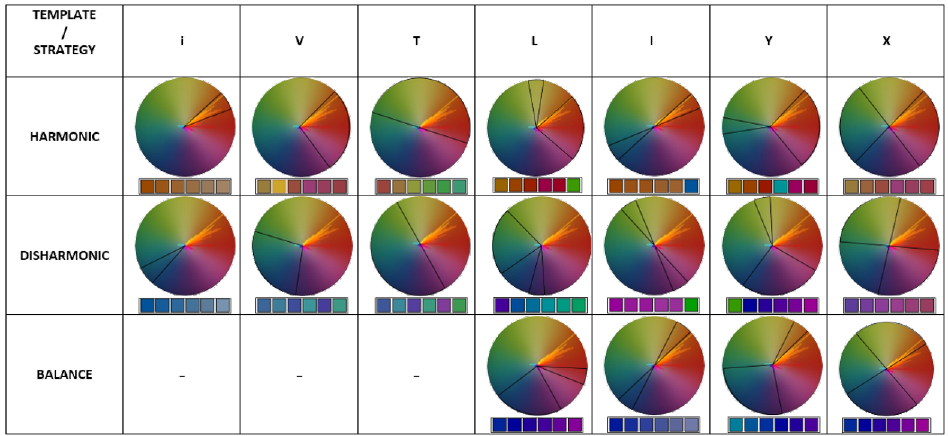
Figure 5. Color schemes and color palettes related to the porcelain owl family.